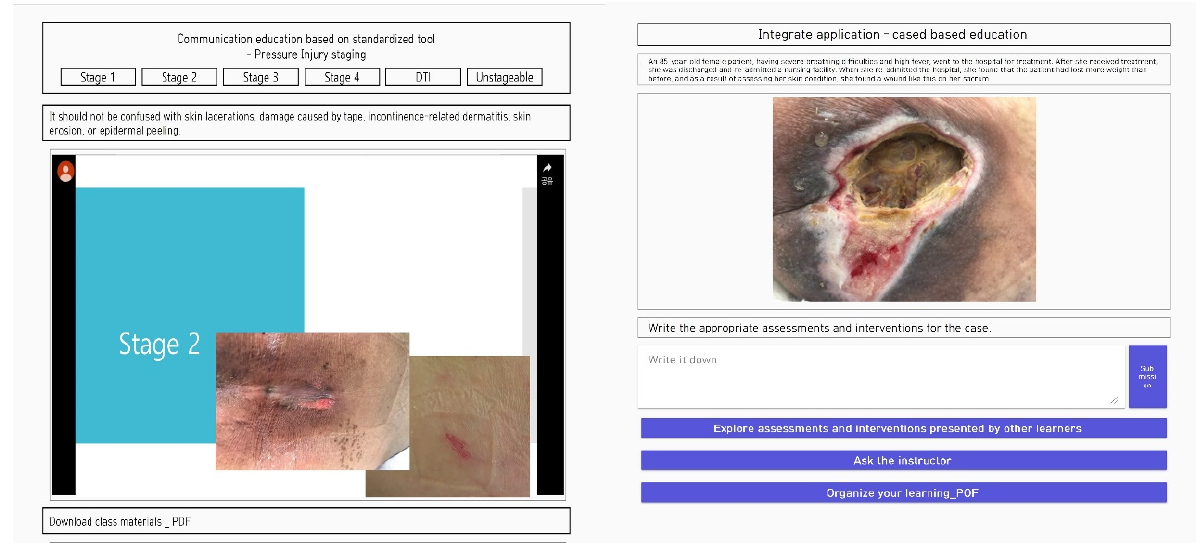
Figure 1. Example illustrations of an educational program for pressure injury management in nurs- ing homes.